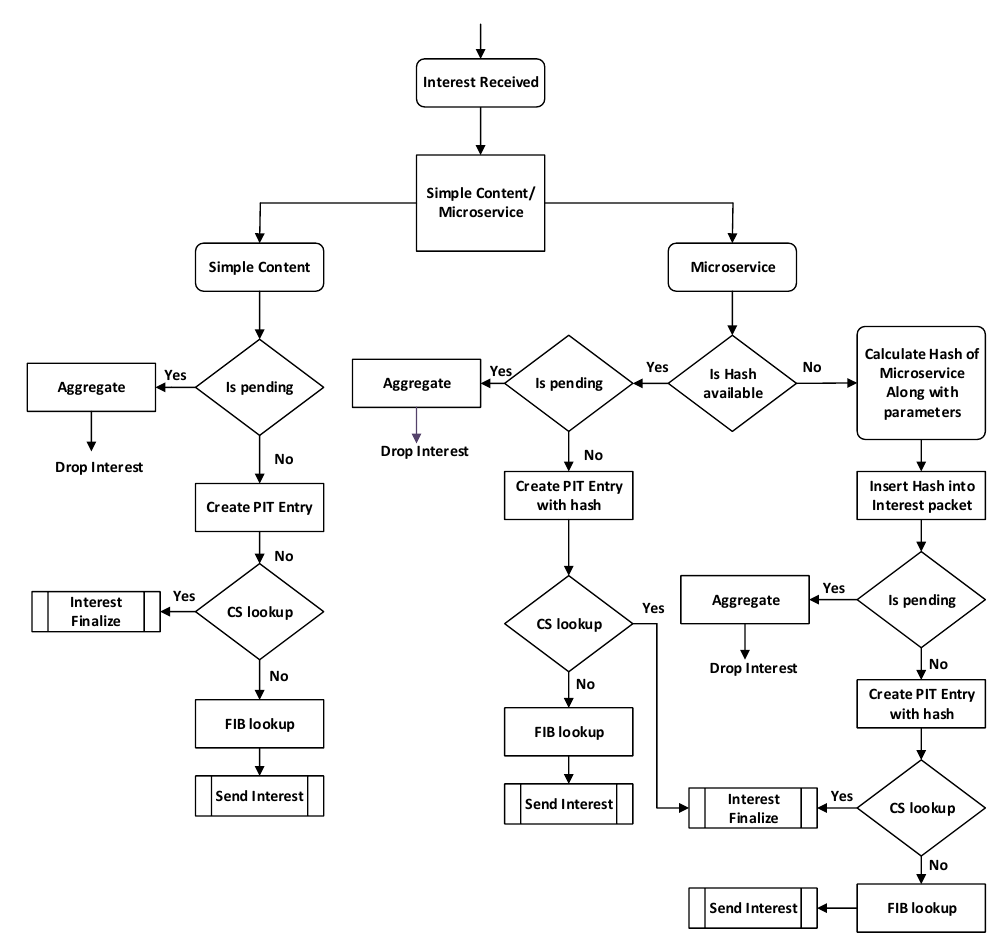
Figure 6. The microservice-centric interest processing